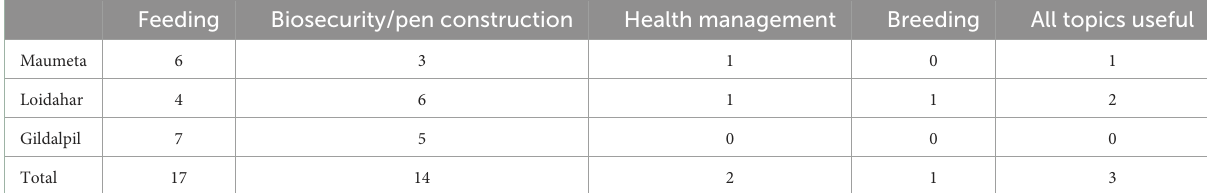
TABLE 7 Most useful training sessions (number of responses) ( N = 27). Feeding Biosecurity/pen construction